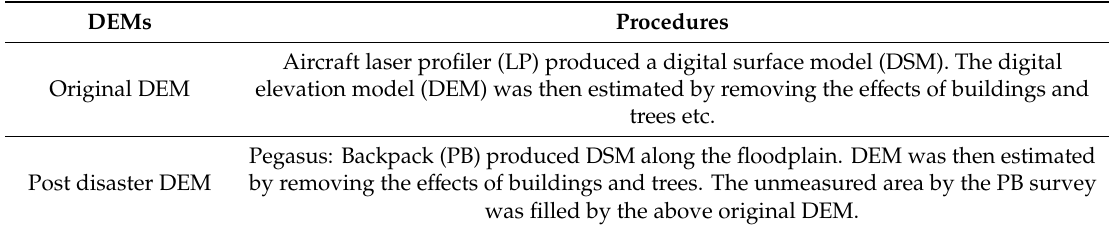
Table 1. Data processing for digital elevation models (DEMs).